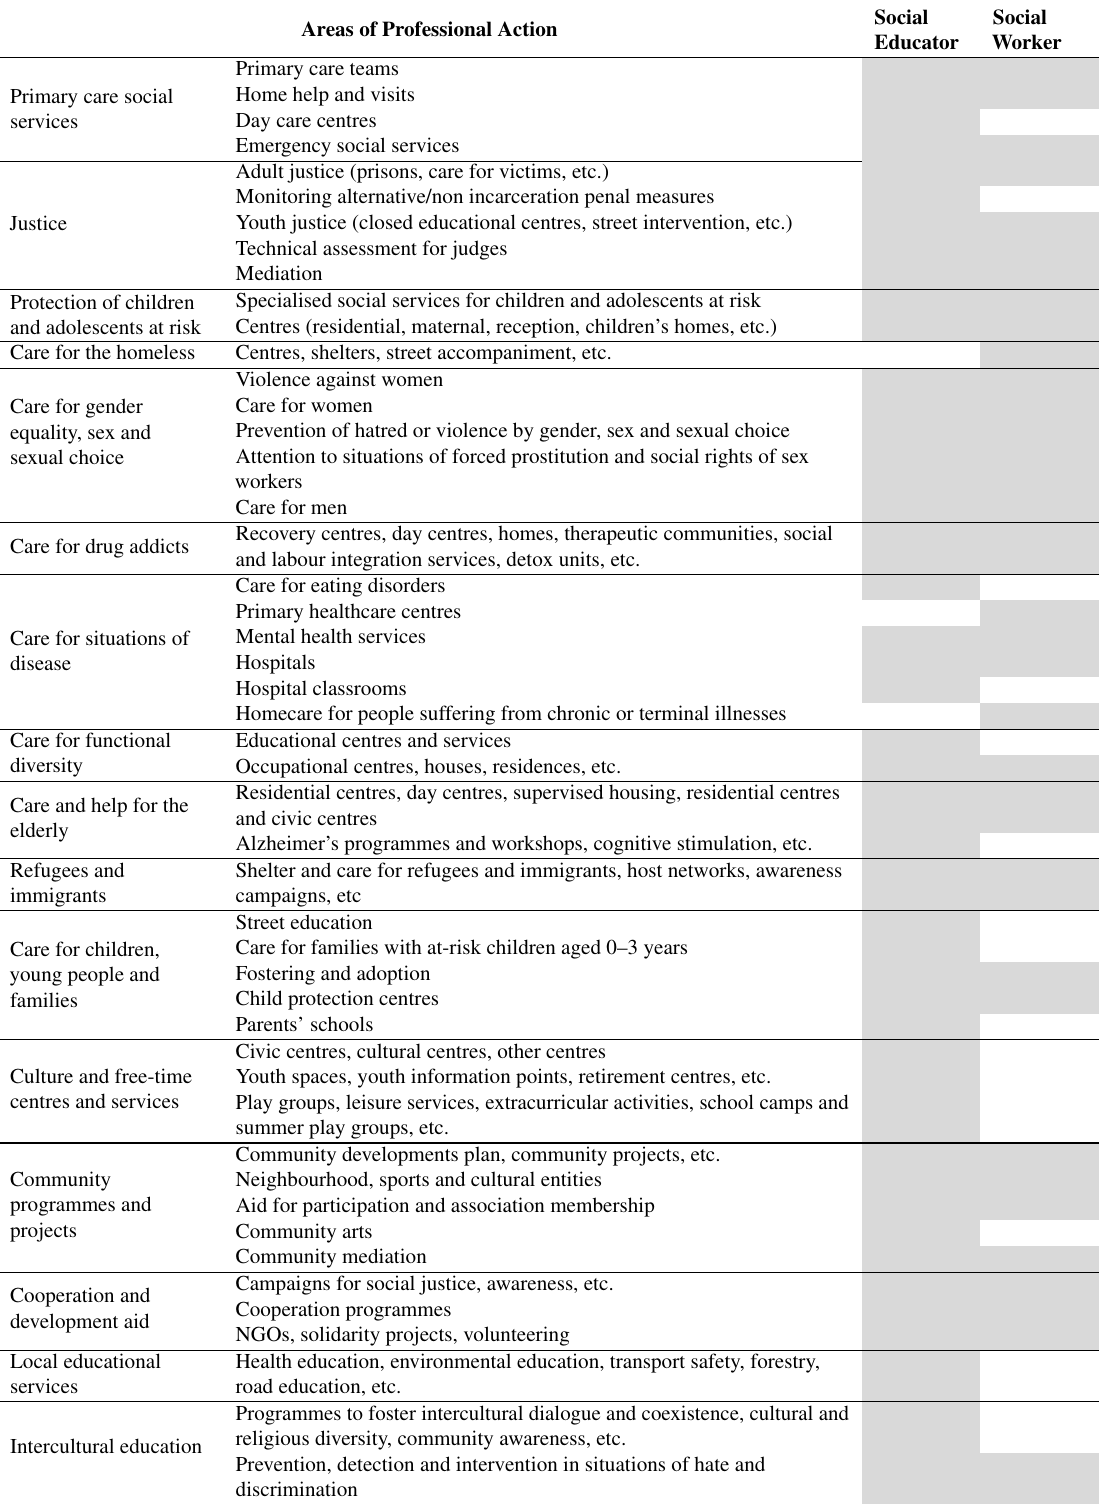
Table 4. Areas of action for social educators and social workers (Source: Author,